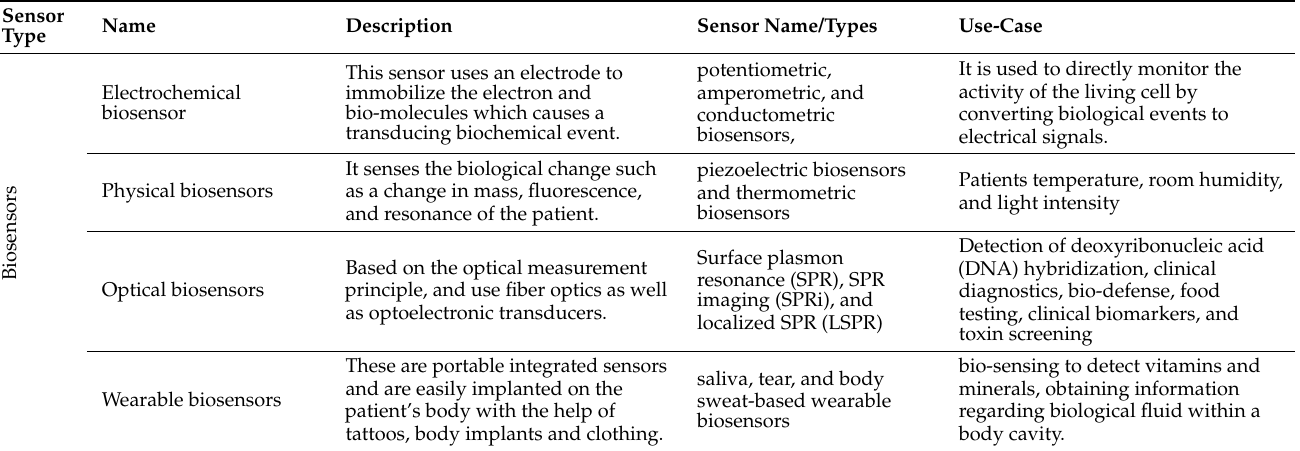
Table 5. Types of sensor devices in IoMT